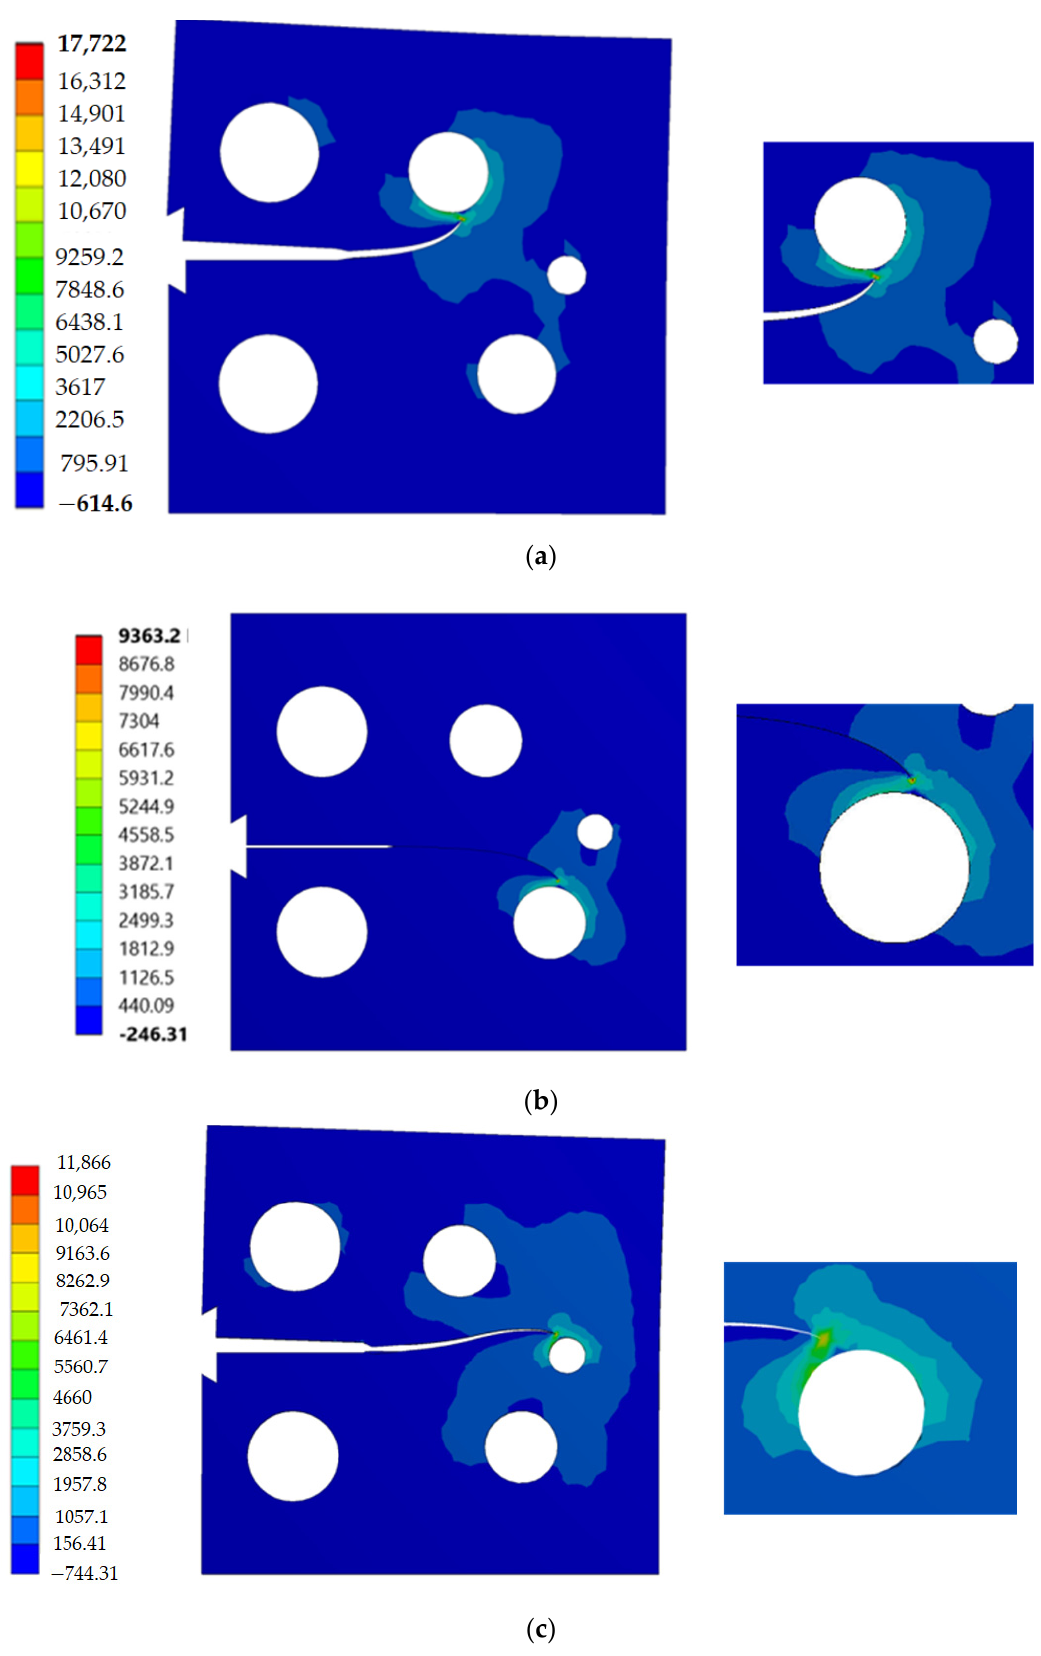
Figure 13. Distribution of maximum principal stress (MPa): ( a ) case 1, ( b ) case 2, and ( c ) case 3.